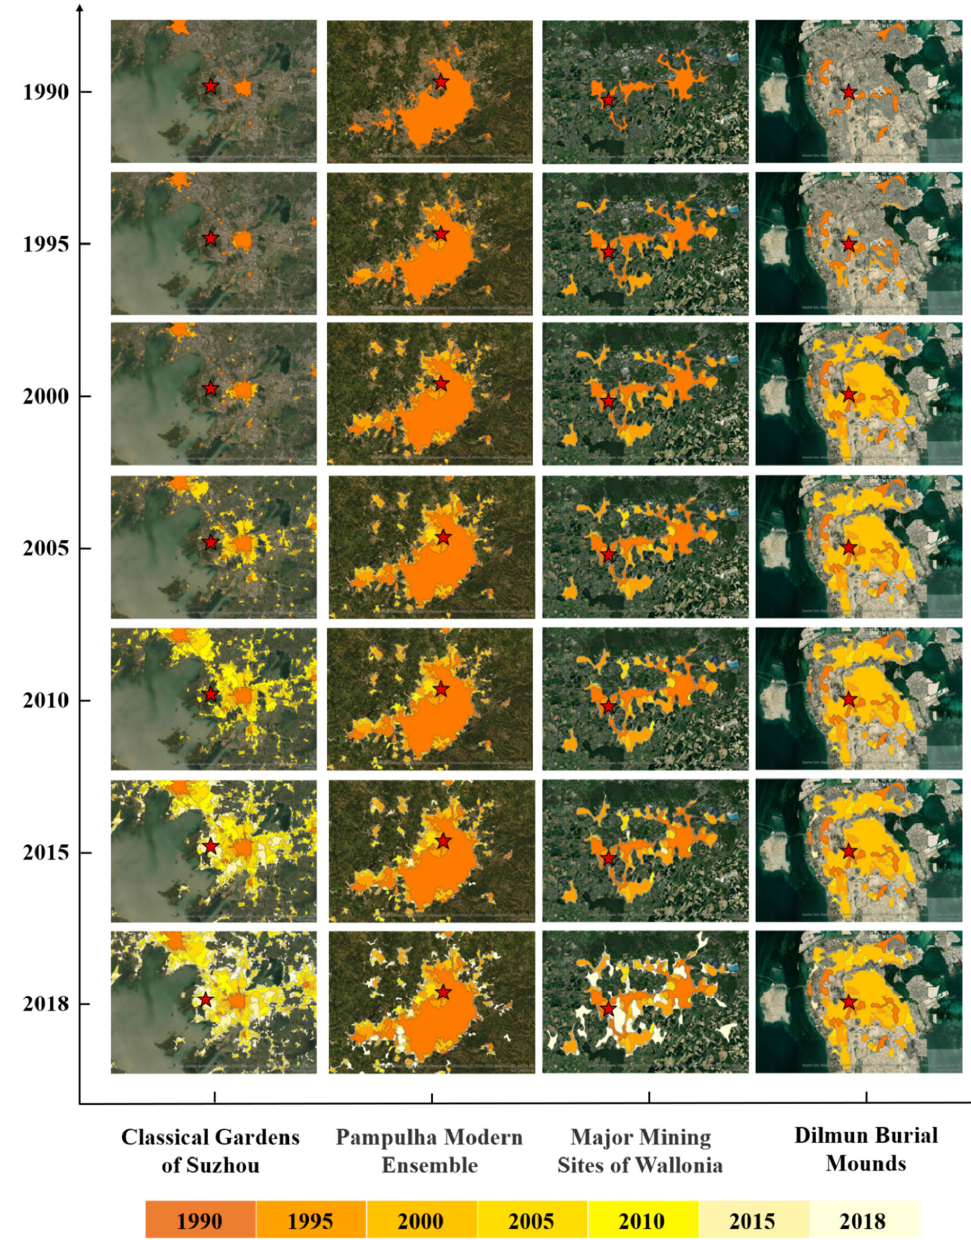
Figure 12. The process by which cultural heritage sites are incorporated into towns.